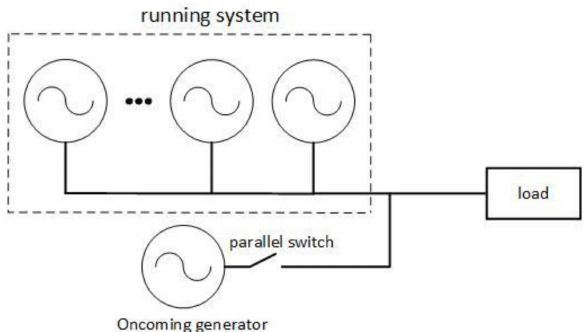
Figure 5. Parallel operation for an oncoming generator that needs to compare and adjust its parameters in order to match those of the running system.